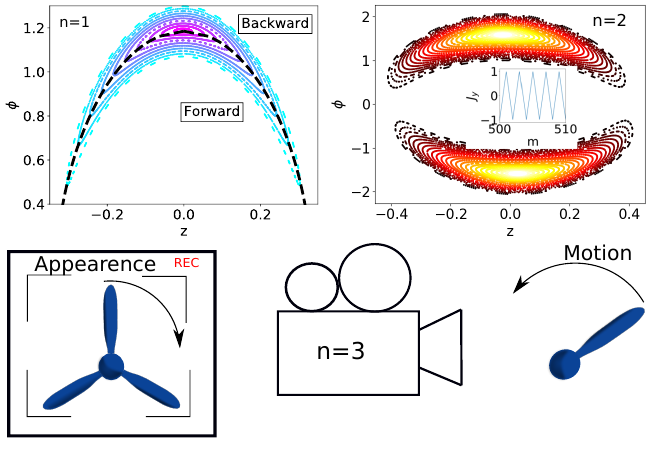
Figure 1: [ Color Online ] The top left figure shows the classical stroboscopic dynamics ) = ( 2.1,0.005 ) . The black line shows the H for an n = 1 resonance with ( t , t 1 2 trajectory with period τ = nt . In the region labeled “Forward” the stroboscopic 1 dynamics appear to move forward along this trajectory (analogous behaviour holds for the region labeled “Backward”). This apparent reversal of motion is equivalent to the stroboscopic aliasing effect observed when the frame rate of a camera is faster than the rotation rate of a helicopter blade. The top right figure shows example ) = ( 1.1,0.05 ) , and it contains an inset of the of an n = 2 resonance with ( t , t 1 2 exact stroboscopic quantum dynamics that displays the n = 2 subharmonic response. The cartoon depicts an example of stroboscopic aliasing effects that occurs when the frame rate of the camera is n = 3 − | ε | times the rotation rate of the